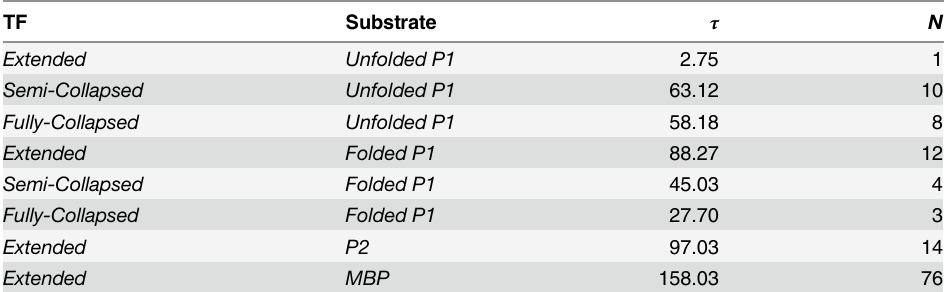
Table 2. Metastability of TF-substrate